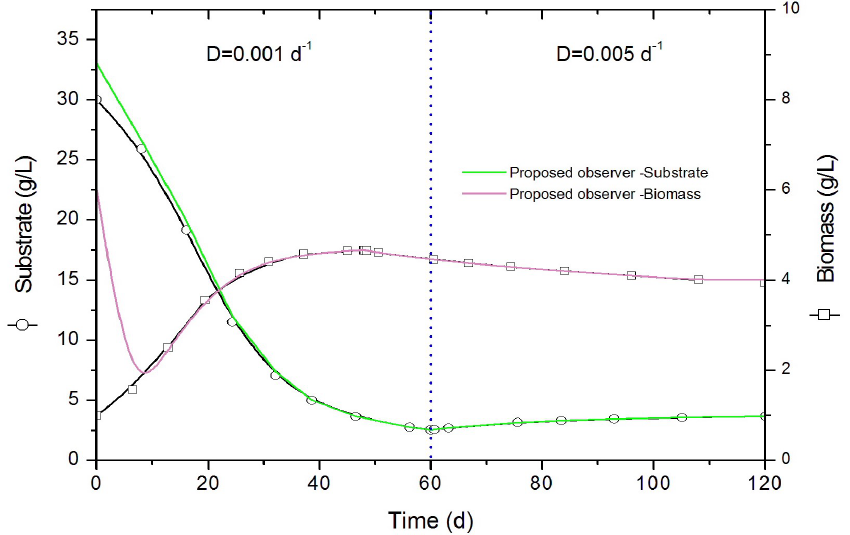
Figure 9. Dynamics of the biomass and nutrients in presence of abrupt disturbance to 60 days on